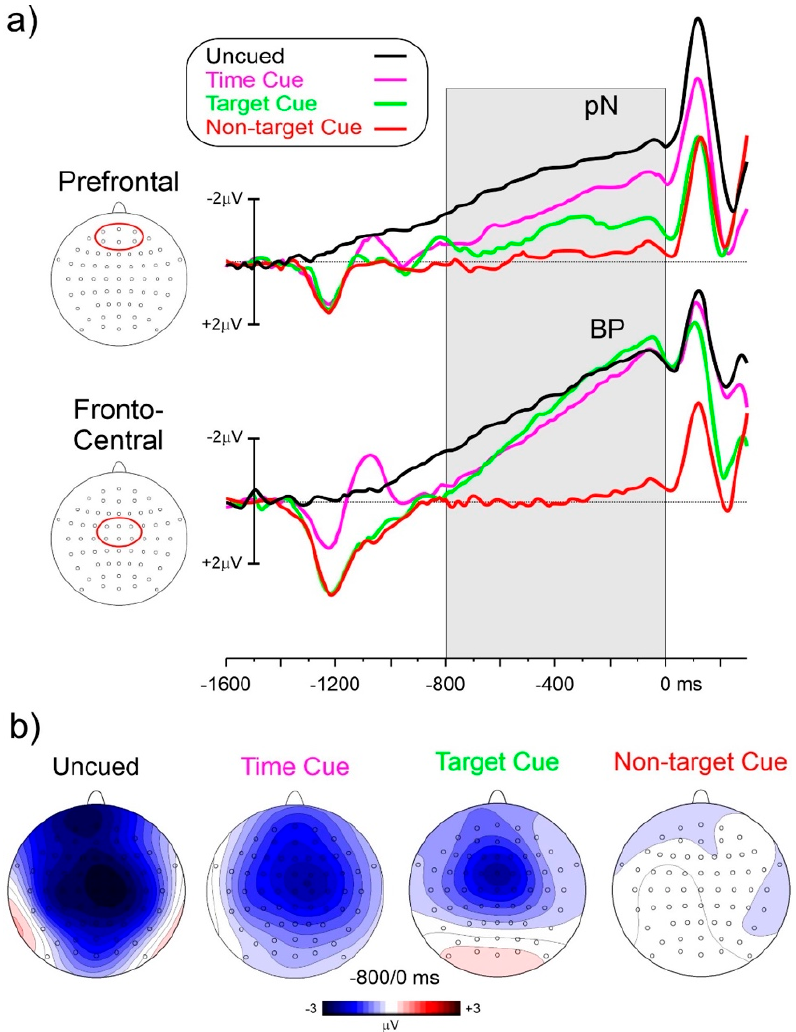
Figure 3. ( a ) ERP waveforms at the medial prefrontal and frontocentral pools of electrodes, which are indicated with a red shape in the head flat-view insets. The grey area indicated the studied interval; ( b ) scalp topography in the window from − 800 to 0 ms showing the prefrontal pN and the frontocentral BP from top-flat views for the studied conditions.